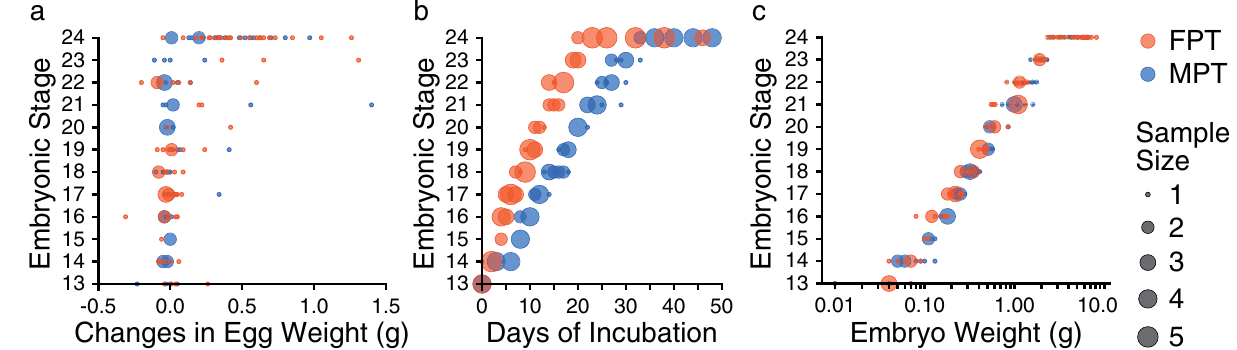
Figure 1. Characteristics of stages 13–24 in Mauremys reevesii as represented by egg weight, incubation days, and embryo weight. ( a ) Egg weight for each stage are shown as a difference that the weight on the day of dissection is subtracted by the weight on the day of arrival. ( b ) Days of incubation from stage 13 required to reach each stage are shown. ( c ) Embryo weight at stages 13–24 are shown without the extraembryonic membranes. FPT and MPT denote female- and male-producing temperatures (31 °C and 26 °C), respectively. The size of dots corresponds to the sample